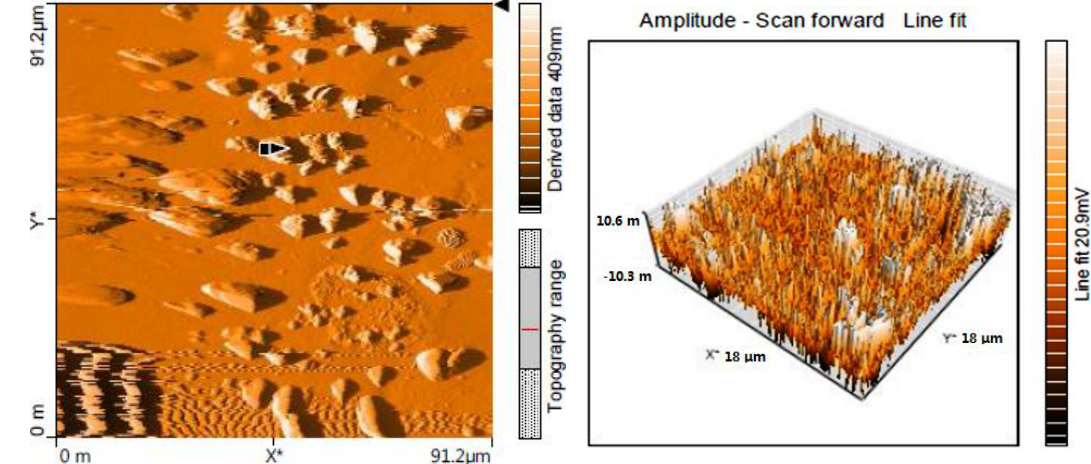
Figure 10. 2D and 3D AFM images of PVC film (control) exposed to UV light for 250 h.